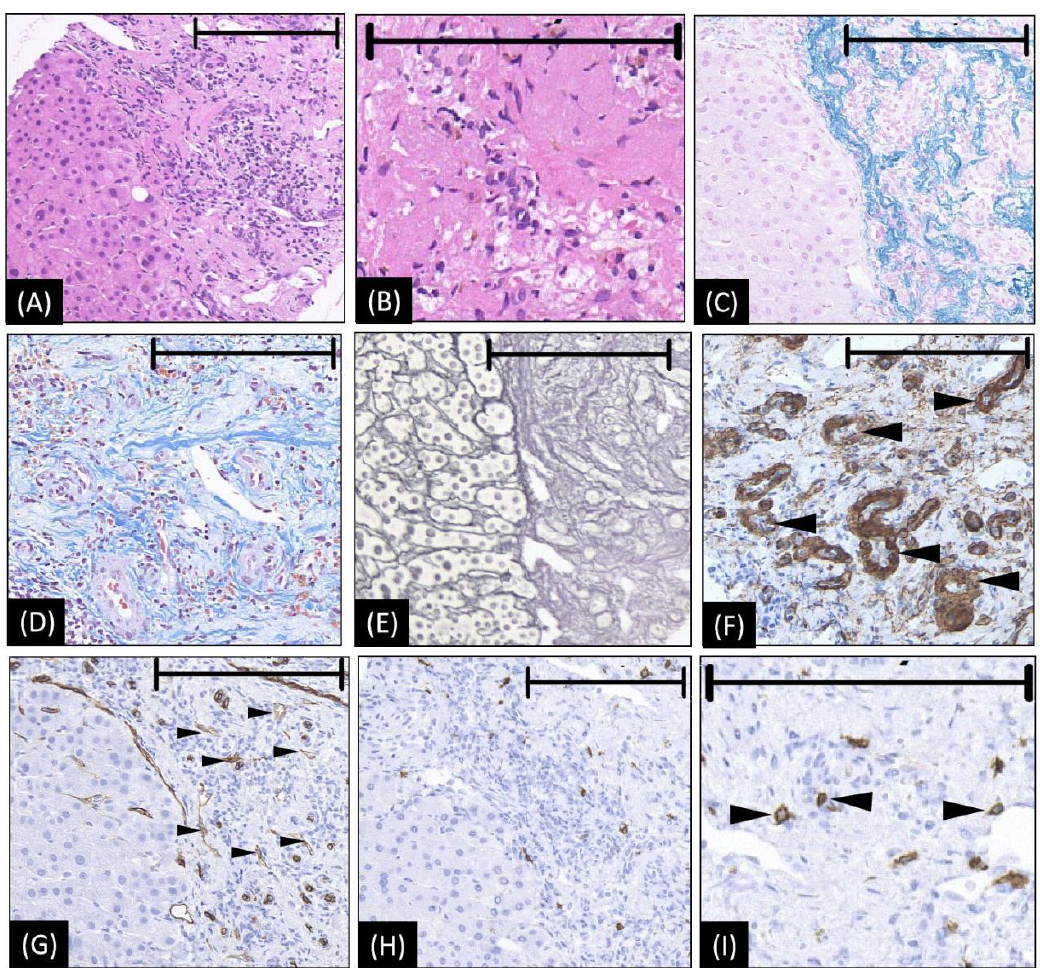
Figure 2. The microscopic appearance of biopsy tissue from HSH (our case). ( A , B ) Hematoxylin– eosin staining reveals abundant collagenous tissue around and between the small vessels. Within the area of fibrogenesis, the hepatocytes and bile duct basically disappeared. ( C ) Victoria blue staining shows abundant elastic fibers of varied thickness are dispersed in the stroma. ( D ) Masson trichrome staining showed a high density of hyalinized collagenous tissue stained in blue around and between small vessels. ( E ) The silver stain shows extensive fibrogenesis. Within the area of fibrogenesis, the hepatocytes and bile duct basically disappeared. The frame of the reticular fiber has changed to a great extent ( F ) The staining of actin on the arterial wall by ɑ -SMA, indicating an increase in arterioles (as arrowheads denoted). ( G ) CD34 is diffusely expressed in endothelial cells of the vessels (small black arrowheads), suggesting the blood vessels proliferated in the sclerosed portion. ( H , I ) CD117 immunohistochemical stains show increased mast cells (black arrowheads in ( I )), which is considered strongly related to angiogenesis and connective tissue hyperplasia. In images A, C, E, G, and H, the left halves show the normal liver area as a reference, while the right halves are the lesion area to show the positive histological changes. The length of the black bar in the upper side of each figure represents 200 microns (µm) as a magnification reference.